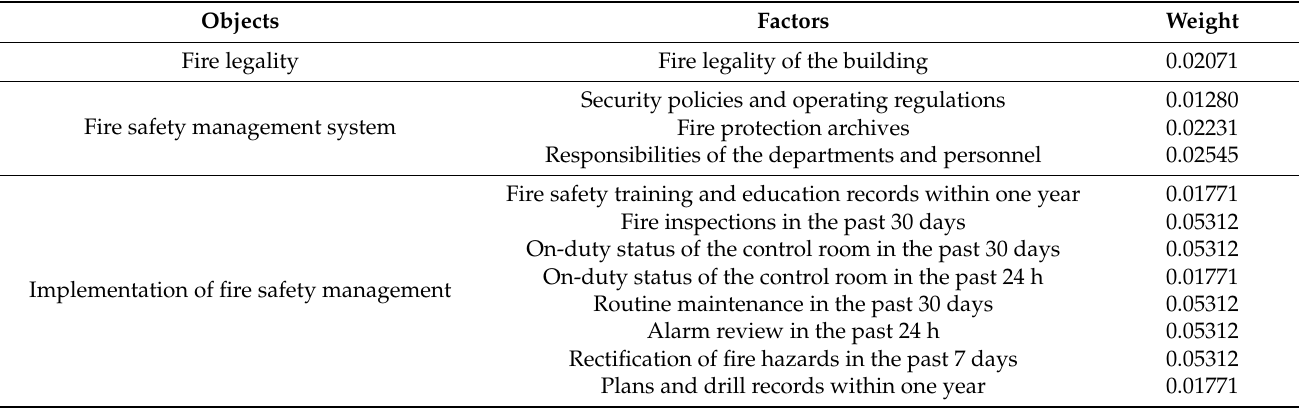
Table A3. The description and weight of each factor under the global factor of fire safety